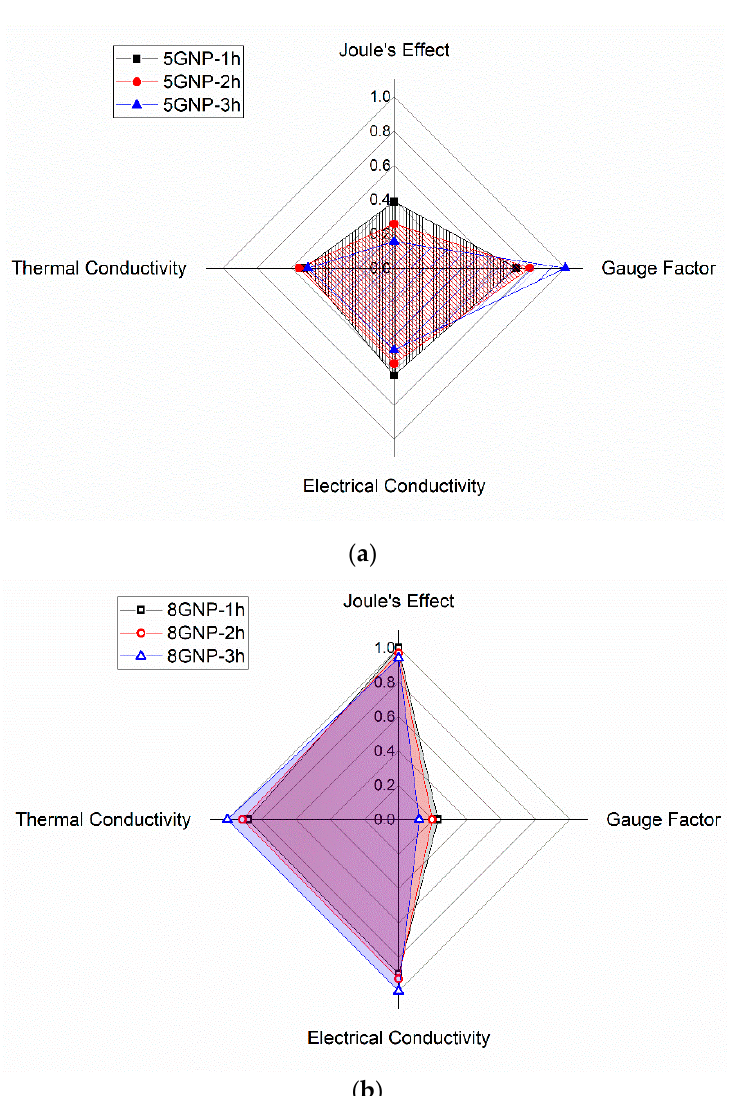
Figure 8. Radar chart of the different tested properties for ( a ) 5GNP and ( b ) 8GNP samples, scaled from 0 to 1.